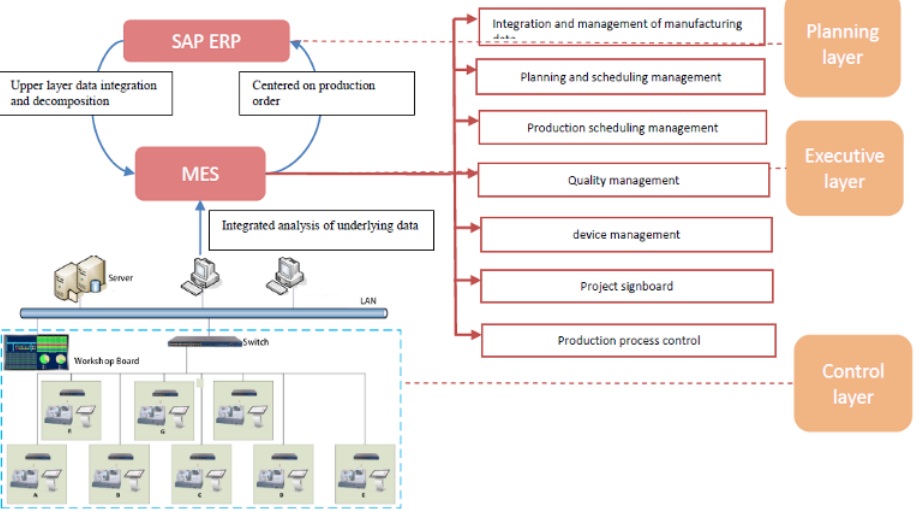
Fig. 3. Overall system